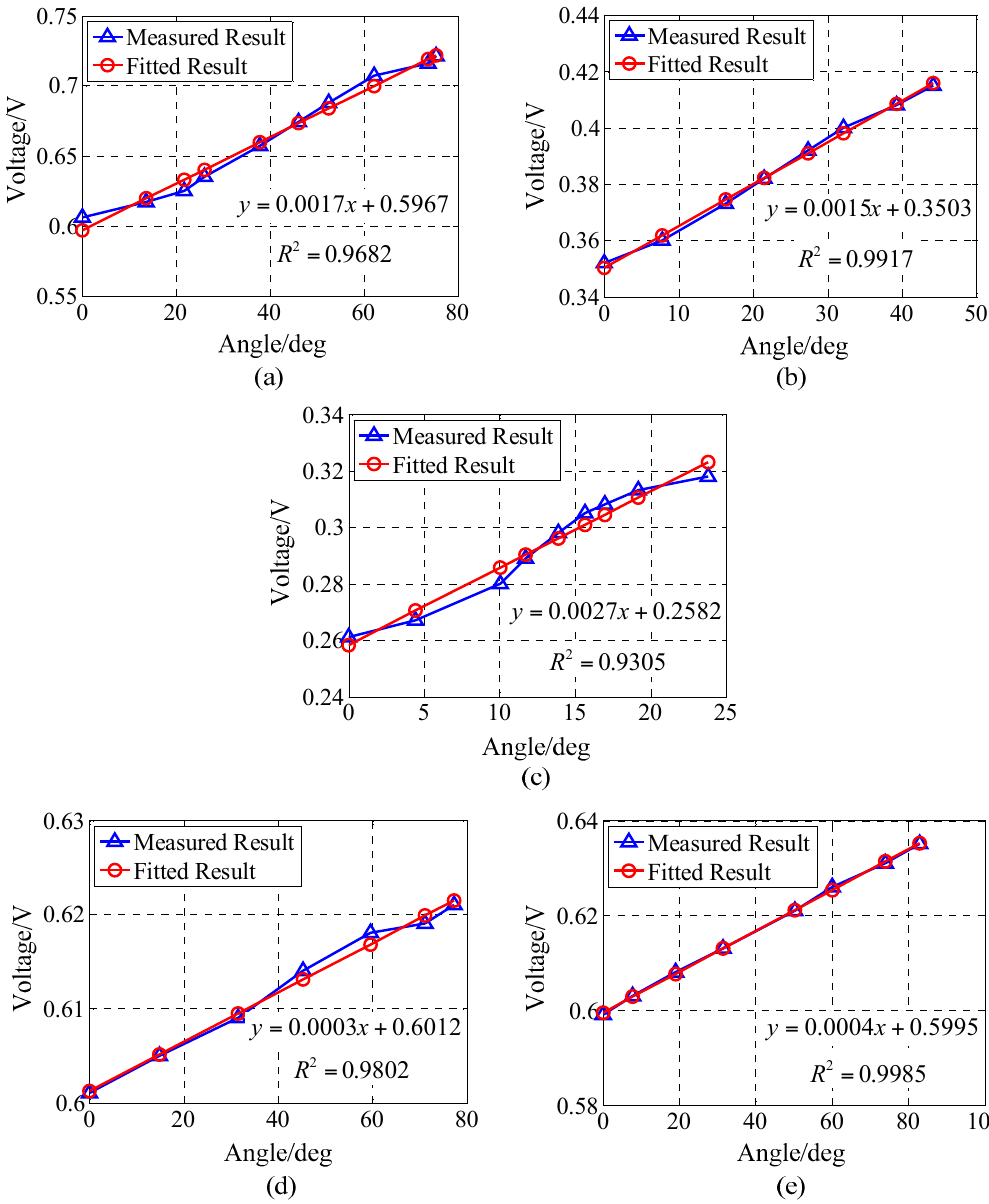
Figure 5. Measurements and linear fitting of wrist motion: ( a ) Flexion; ( b ) Extension; ( c ) Ulnar deviation; ( d ) Pronation; ( e ) Supination.